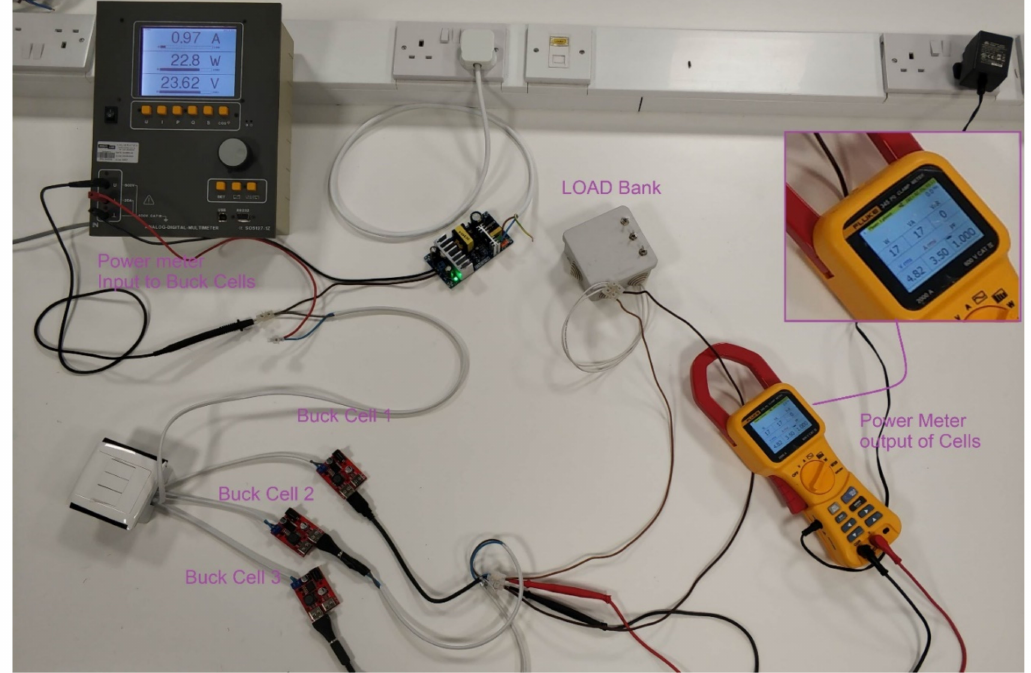
Figure 5. Experimental setup with parallel buck converter